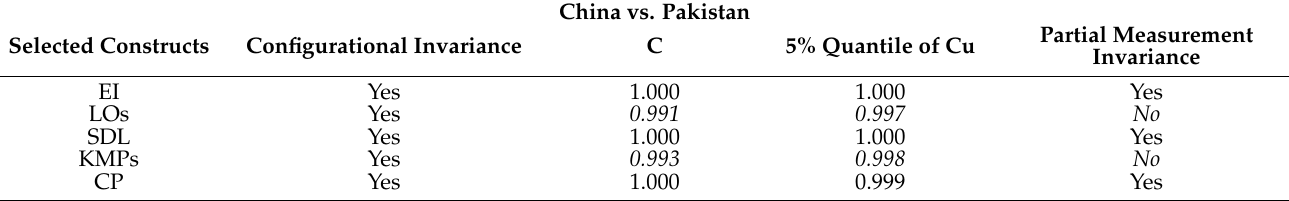
Table 11. Compositional